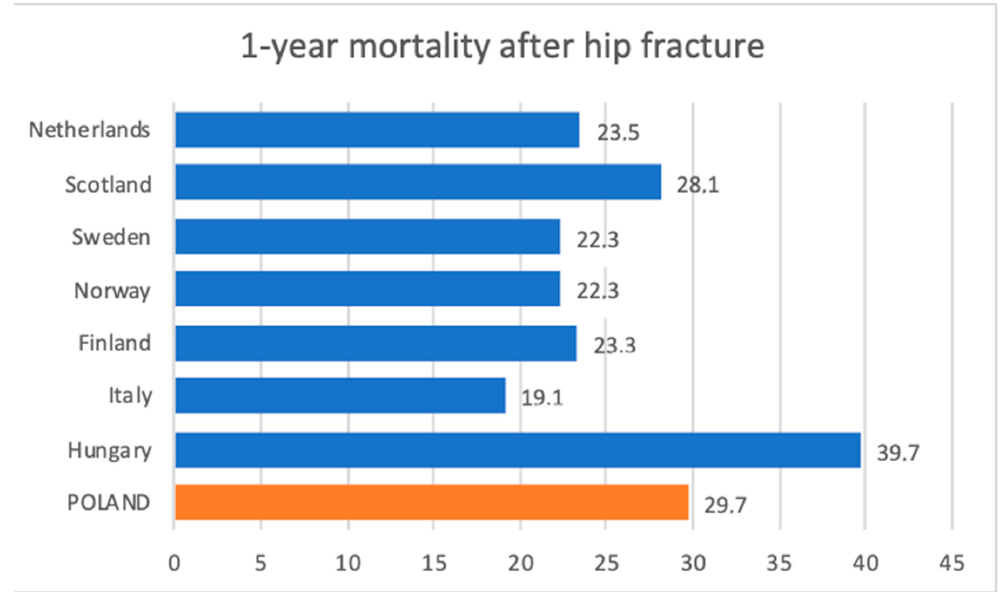
Figure 13. 1-year mortality percentage after hip fracture—comparison between selected European countries. Calculations for Poland were made based on our data.